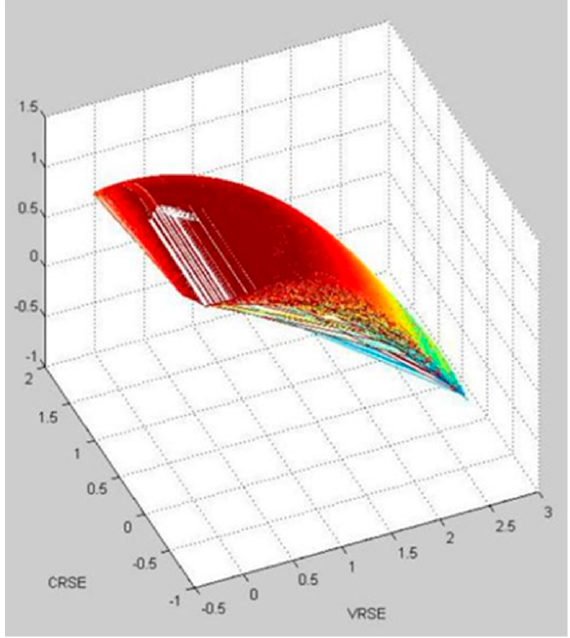
Figure 7. The visualization of simulation of the effect of Chinese outward FDI on wellbeing in Group 1.